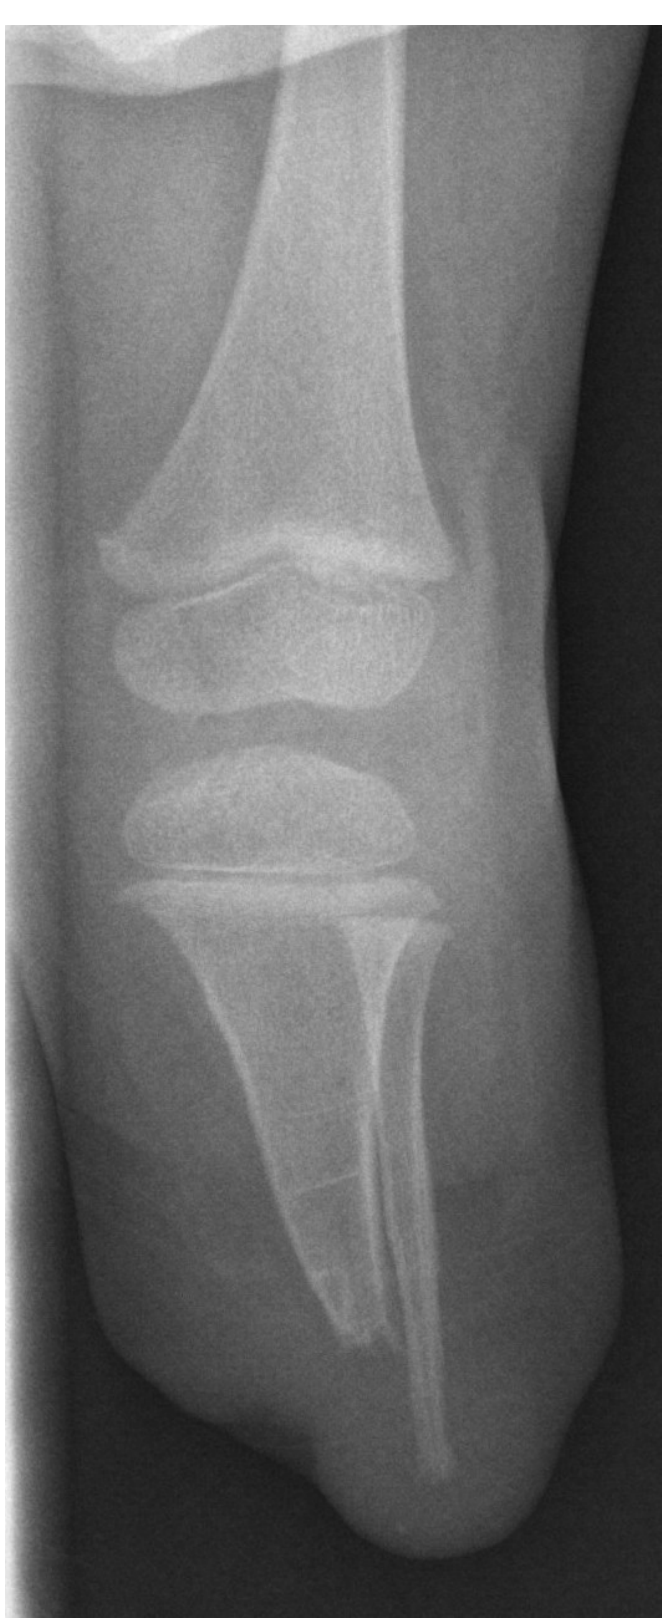
Figure 2. Postoperative X-ray of transtibial amputation .